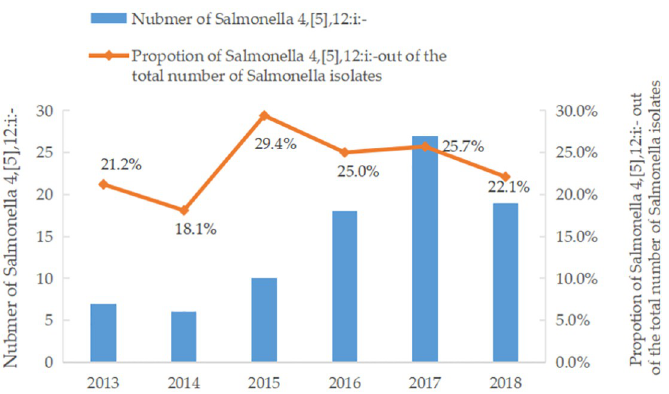
Fig 1. Detection of Salmonella 4,[5],12:i:- isolates from Guizhou, 2013–2018.